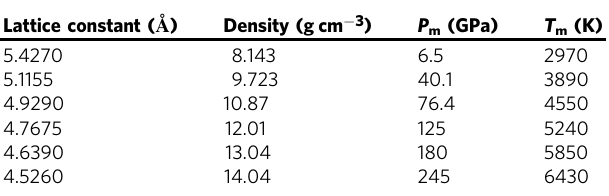
Table 2 The six ab initio melting points of orthorhombic Pnma -Nb, ( P T m , m ), obtained from the implemented with